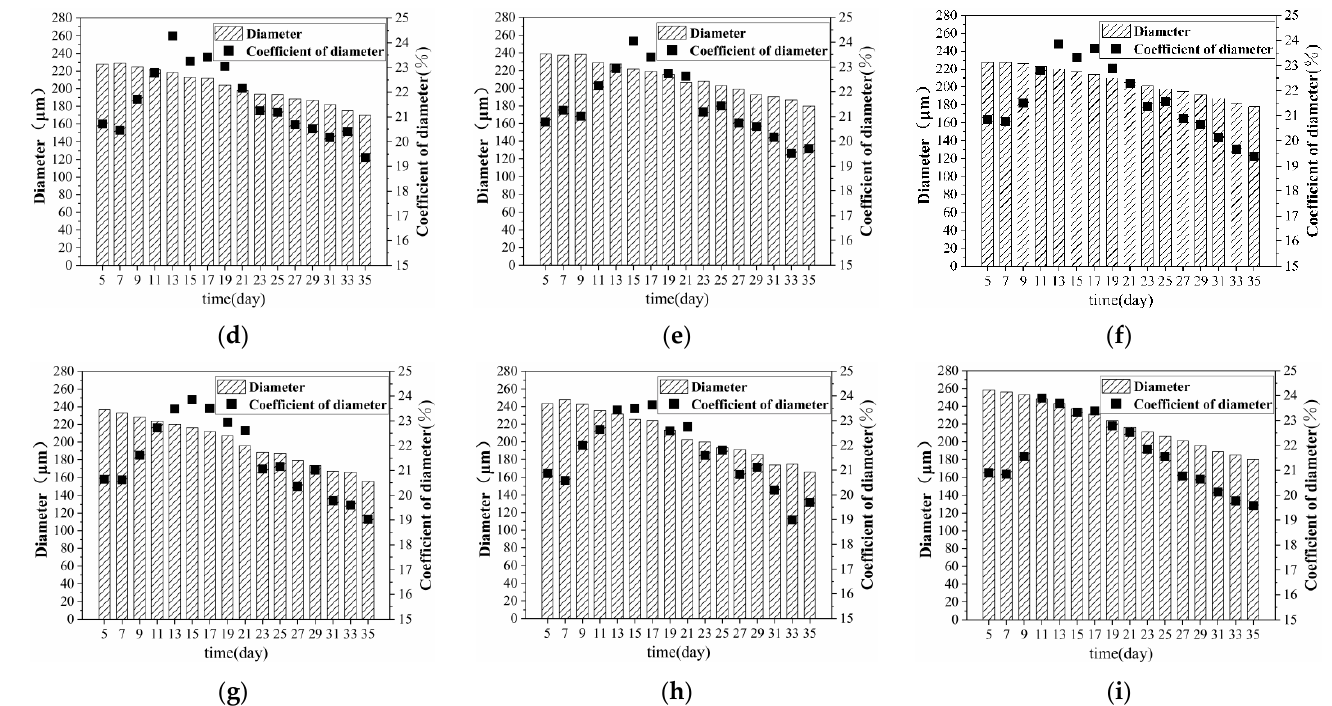
Figure 7. Diameter of fibre in different parts of banana stem ( a ) A Ⅰ ; ( b ) A Ⅱ ; ( c ) A Ⅲ ; ( d ) B Ⅰ ; ( e ) B Ⅱ ; ( f ) B Ⅲ ; ( g ) C Ⅰ ; ( h ) C Ⅱ ; ( i ) C Ⅲ .